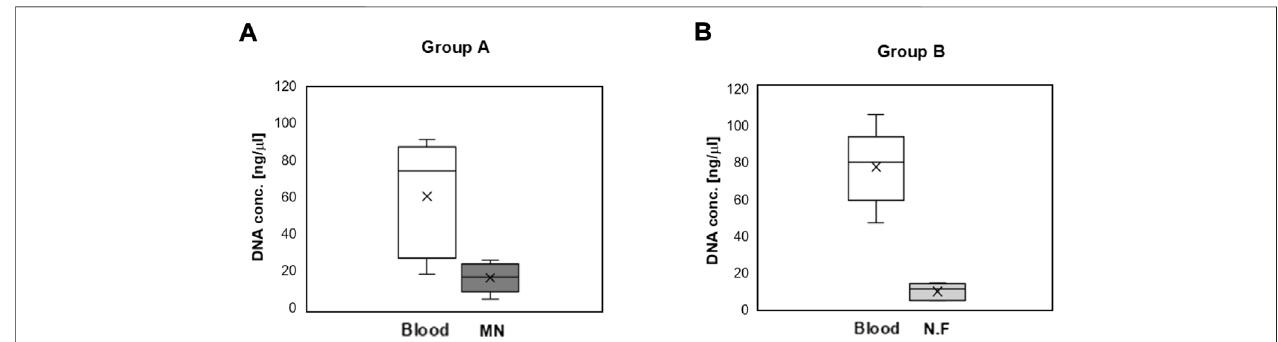
FIGURE 14 | DNA concentration obtained from the blood and oral mucosa of mini-pigs. Oral mucosa was obtained by swabbing 10 times using a Z-N4-I2-S20 microneedle swab or a Copan eSwab ® nylon fl ocked swab (N.F) (n = 5). (A) Group A: The DNA concentration from a blood sample compared with that from a mucosa sample collected with a MN swab. (B) The DNA concentration from a blood sample compared with that from a mucosa sample collected with a N.F swab (Copan eSwab ® ) (MN: Microneedle swab, N.F: Nylon Flocked swab).